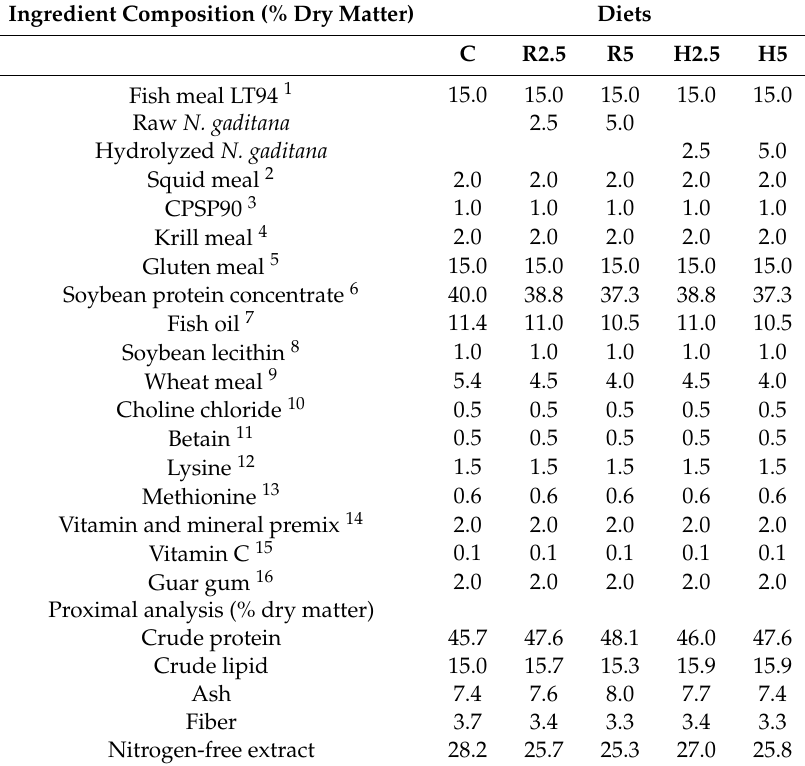
Table 1. Ingredient composition of the experimental